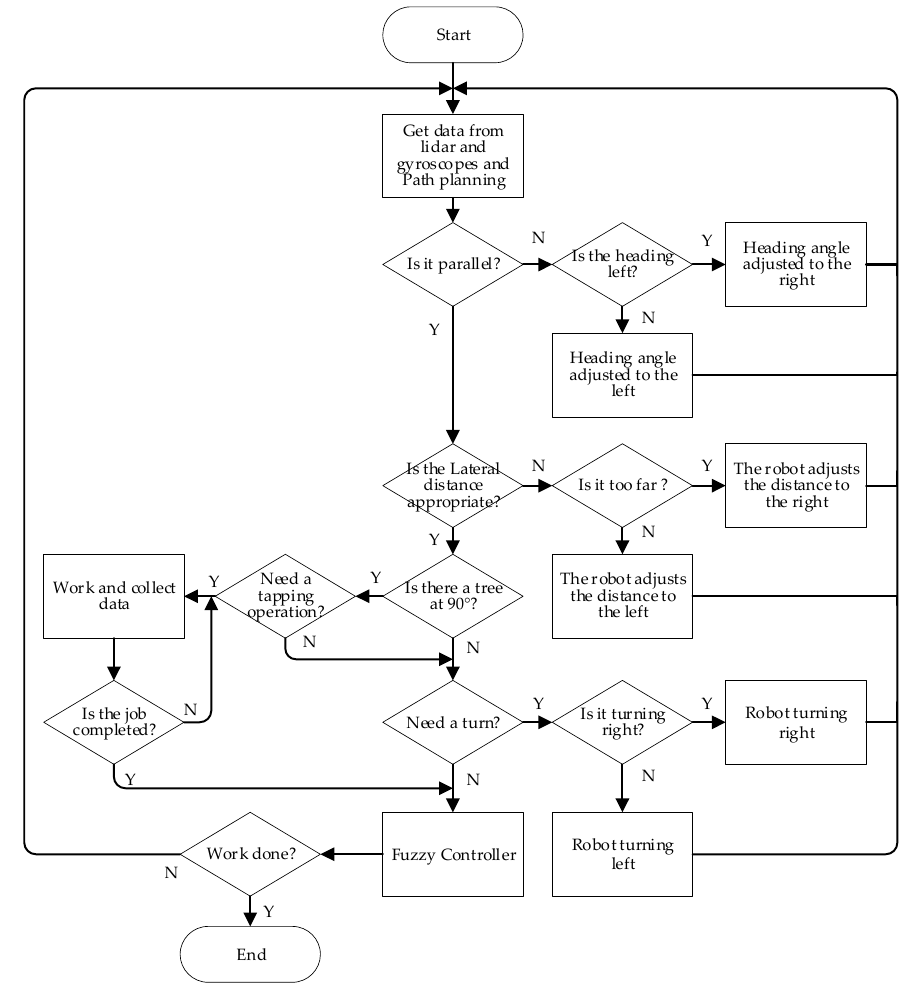
Figure 9. The flow chart of navigation control.